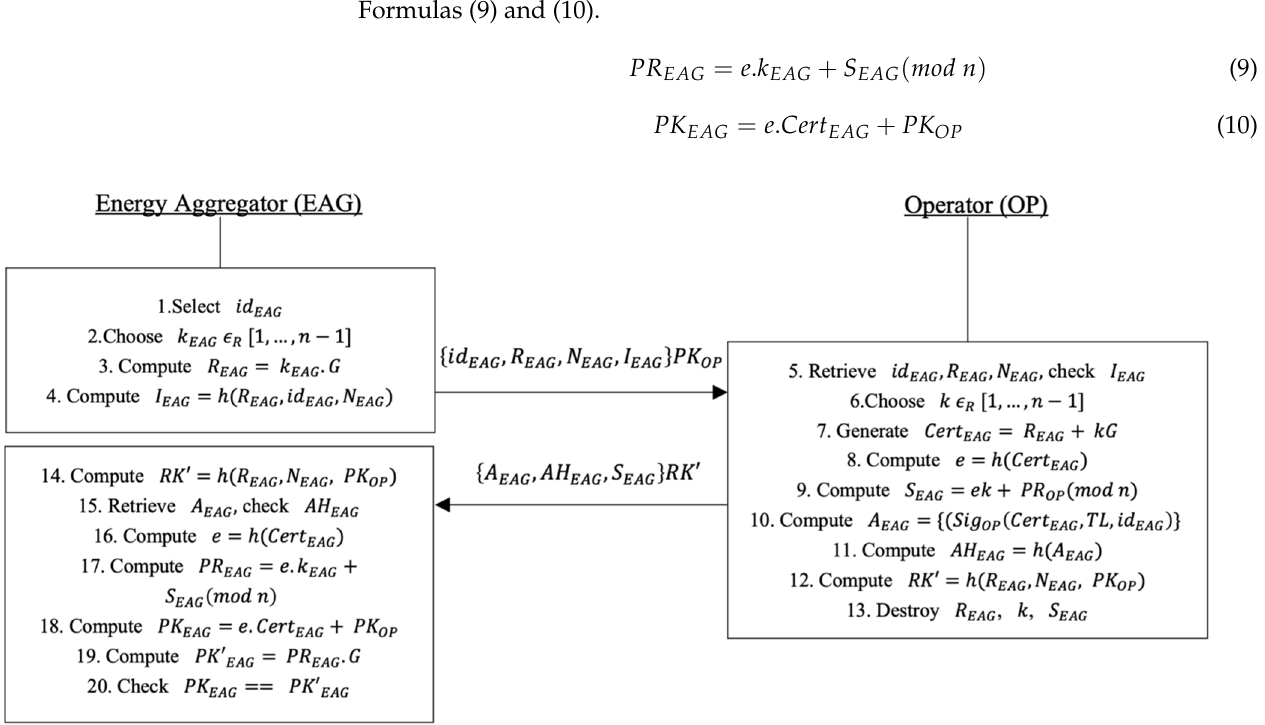
Figure 5. The proposed EAG registration phase.